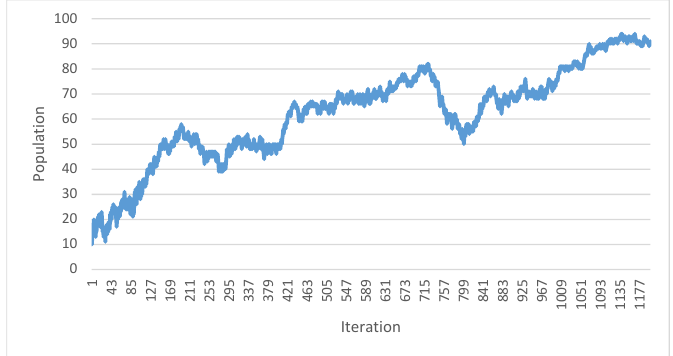
Figure 5. Population size evolution in the autonomous approach, while solving the instance